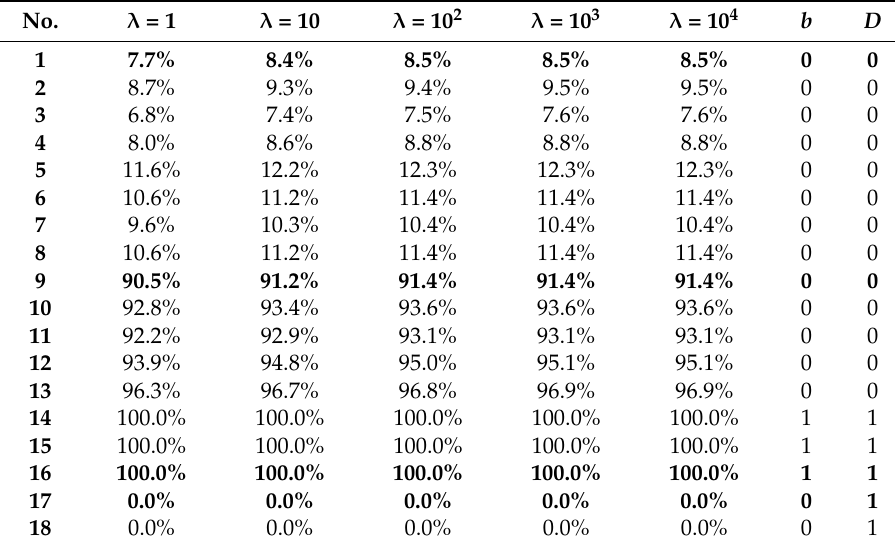
Table 12. The influence of λ on the final α .